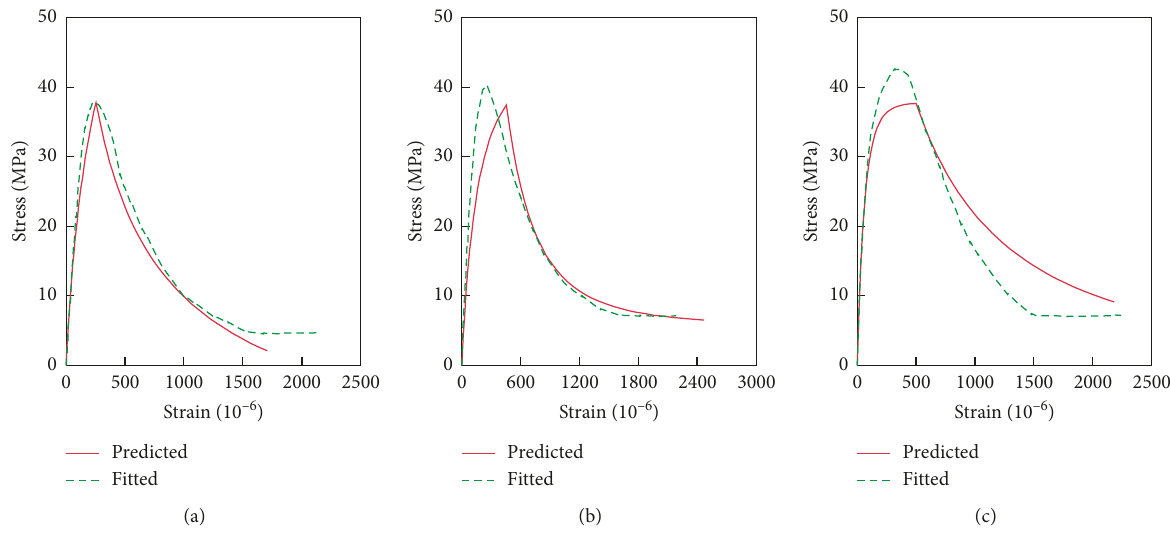
Figure 14: Predicted and fitted stress-strain curves. (a) Sample of Group 1. (b) Sample of Group 2. (c) Sample of Group